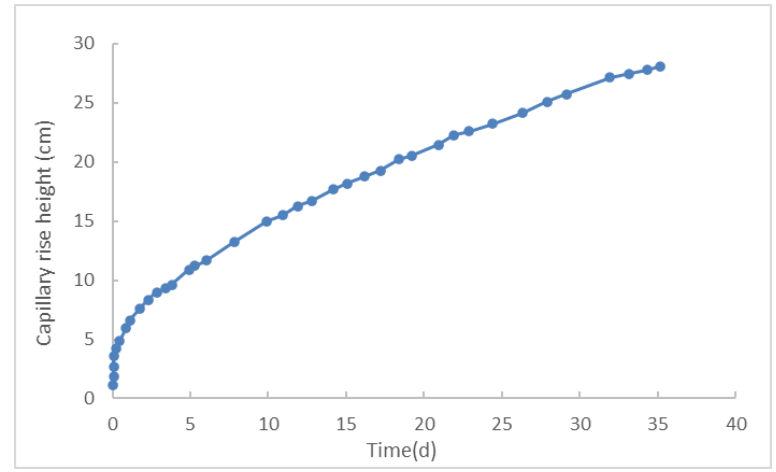
Figure 6. Accumulation curve of capillary height in the loam.